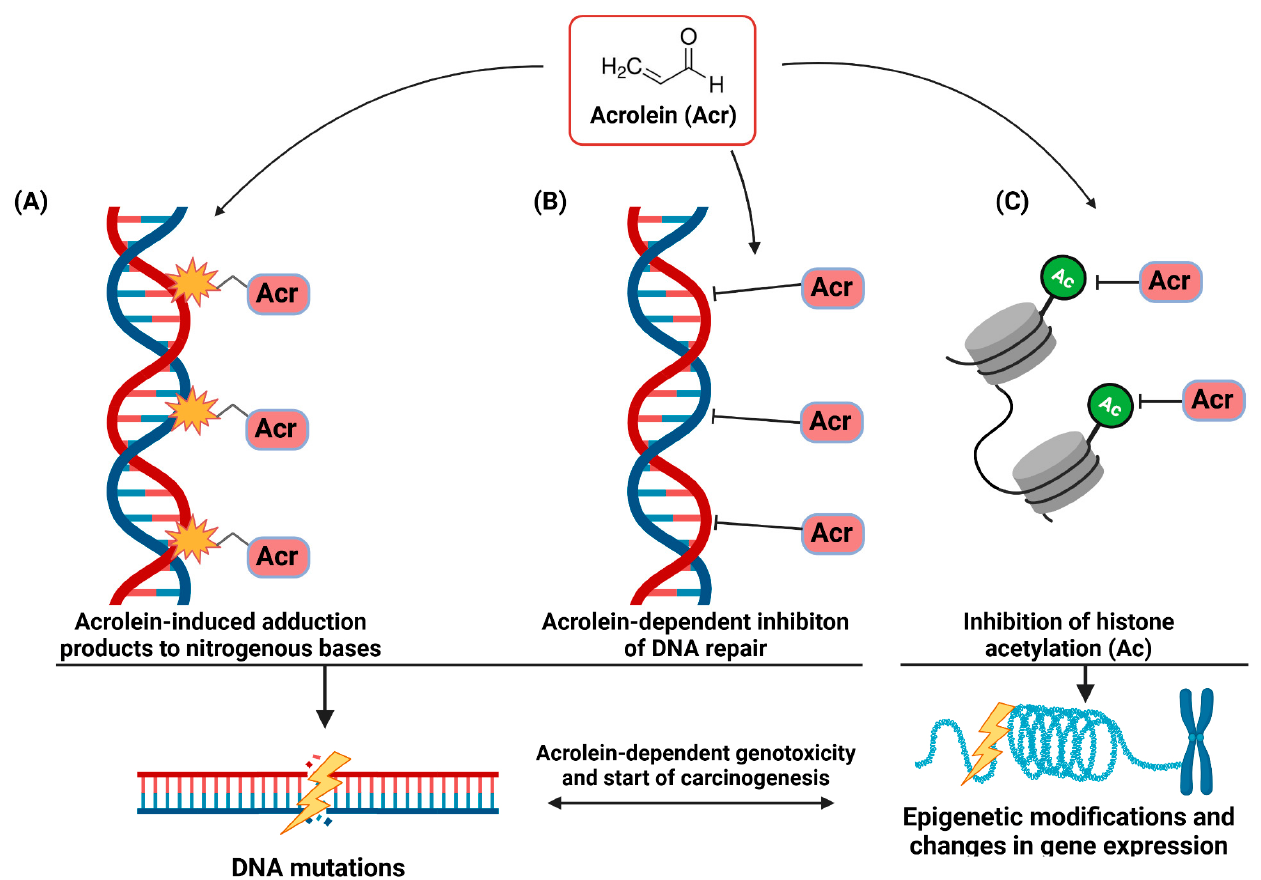
Figure 2. The genotoxic properties of acrolein (Acr) seem crucial in inducing cancer mutations in smokers. Acrolein interacting directly with nucleotide bases forms Acr-nucleotide base adducts and thus leads to their chemical modification ( A ). Effective acrolein-dependent weakening of the activity/inhibition of DNA repair enzymes amplifies the resulting DNA damage and mutations in cells ( B ). Additionally, acrolein affects the epigenetic mechanisms of gene expression regulation by inhibiting histone H4 acetylation ( C ).